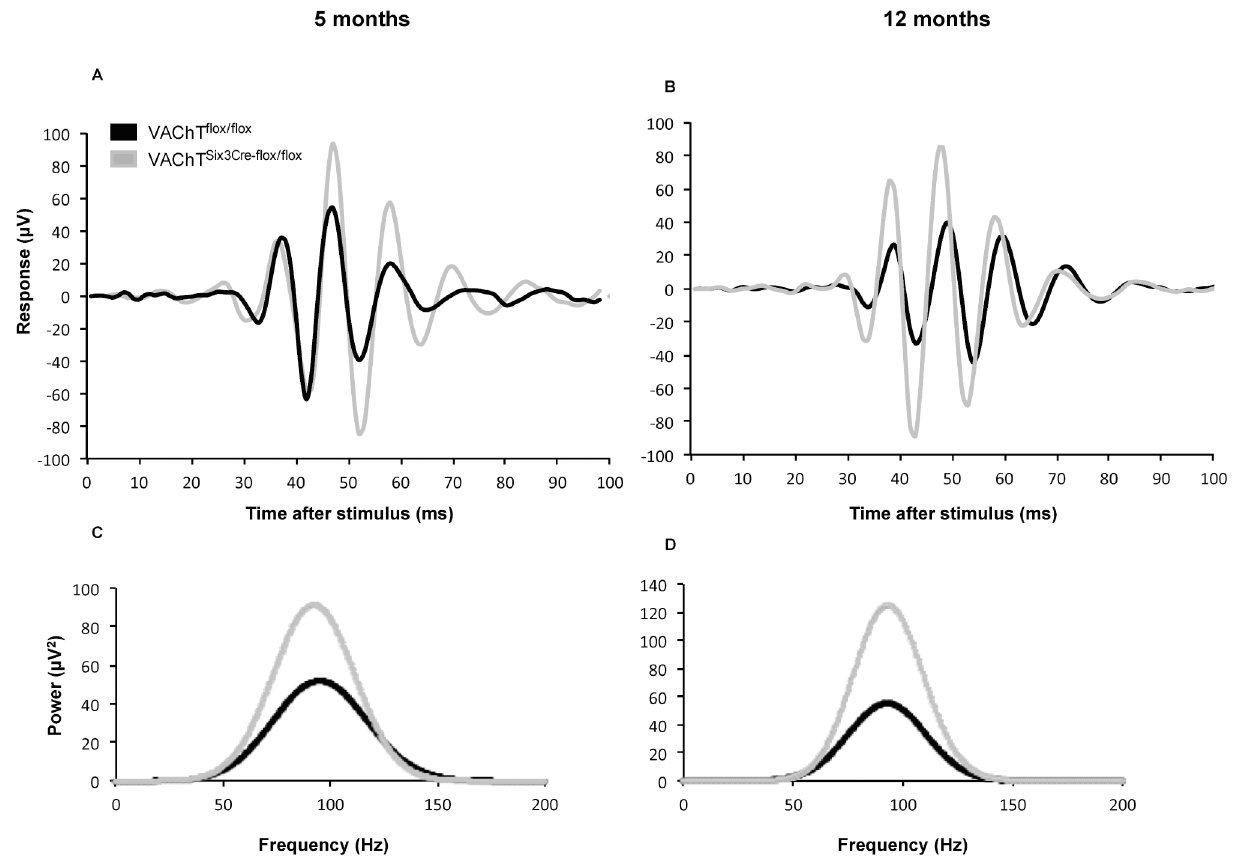
Fig 6. Characterization of OP parameters elicited by VAChT Six3-Cre-flox/flox and control mice under scotopic conditions in response to 10 cd (cid:129) s/m 2 light stimulus. (A-B) VAChT Six3-Cre-flox/flox retinas show reductions in individual OP amplitudes in the time-domain representation of ERG OP parameters at (A) 5 and (B) 12 months of age. (C-D) VAChT Six3-Cre-flox/flox retinas also show reductions in OP total energy and power in the frequency-domain representation of ERG OP parameters at (C) 5 and (D) 12 months of age.